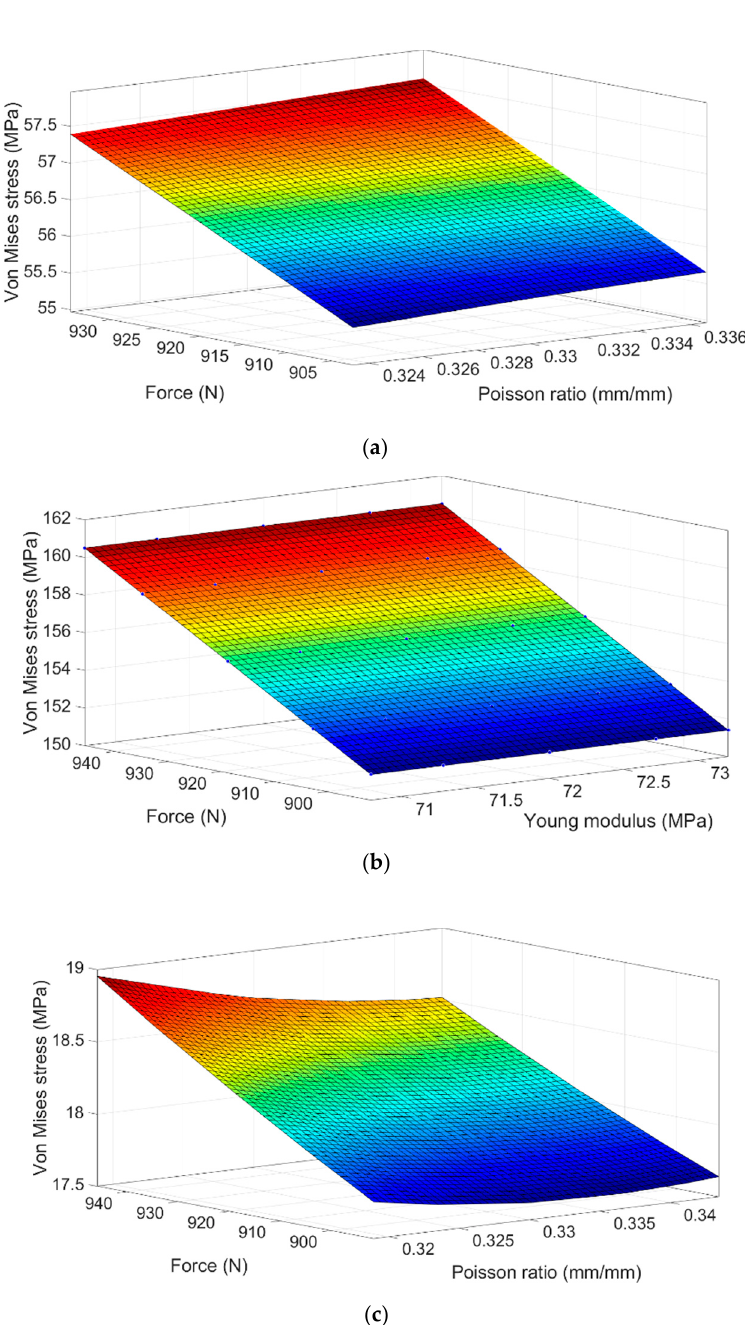
Figure 15. Response surface based in the material properties for the rosette zone: ( a ) #1, ( b ) #2 and ( c ) #3.